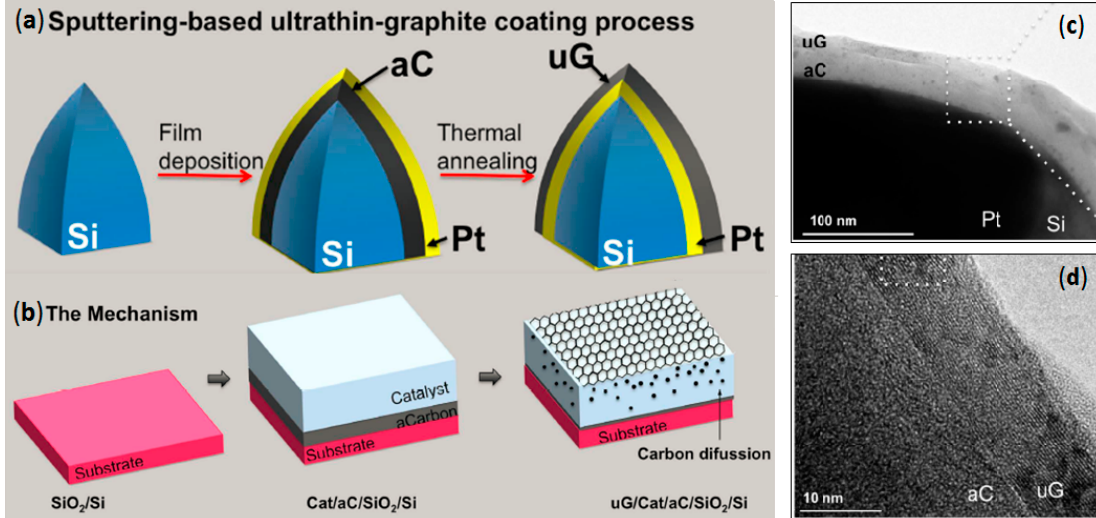
Figure 4. Ultrathin graphite growth on high aspect ratio features. ( a ) Schematic of the growth process on a 3D shaped AFM nanoprobe; ( b ) Growth mechanism of thin graphite by thin film deposition technology and thermal annealing; Cross-sectional TEM image of the resulting graphite coated AFM tip in low ( c ) and high ( d ) magnification. Reproduced with permission from [27], copyright Springer Nature Publishing Group